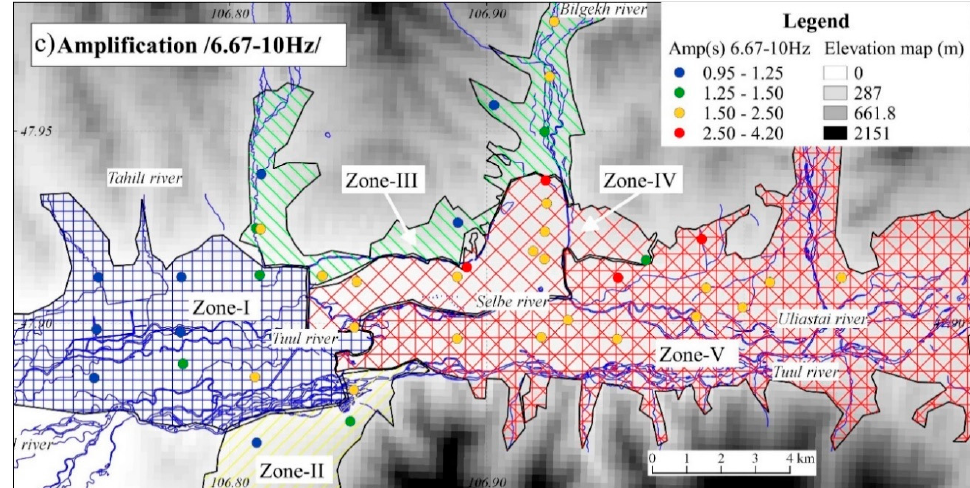
Figure 10. Distribution of site amplifications with the zoning map for ( a ) 1.0–1.25 Hz, ( b ) 3.33–5.0 Hz,